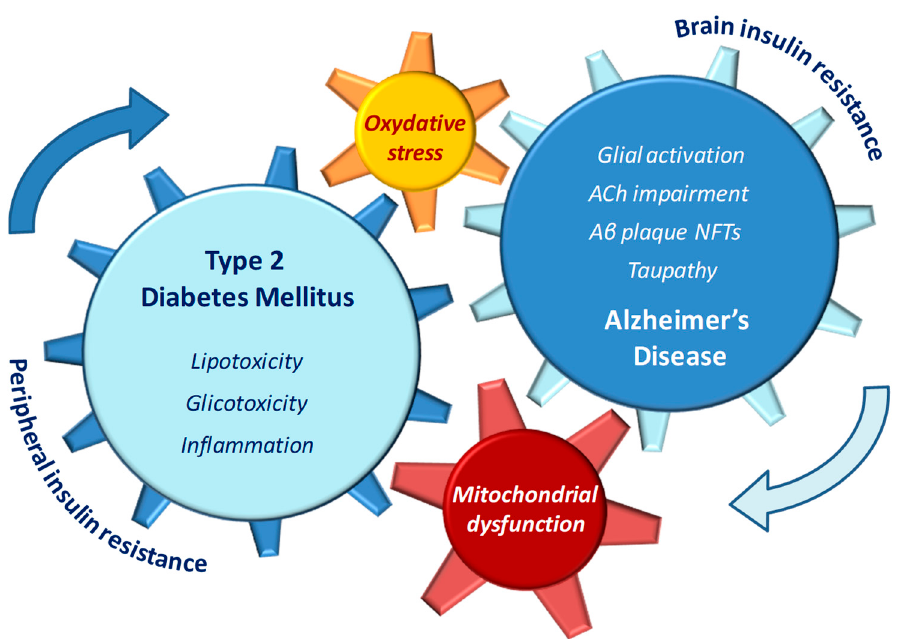
Figure 1. Pathophysiological features of type 2 diabetes (T2DM) and Alzheimer’s disease (AD) that may reciprocally influence and reinforce the progression of both diseases.